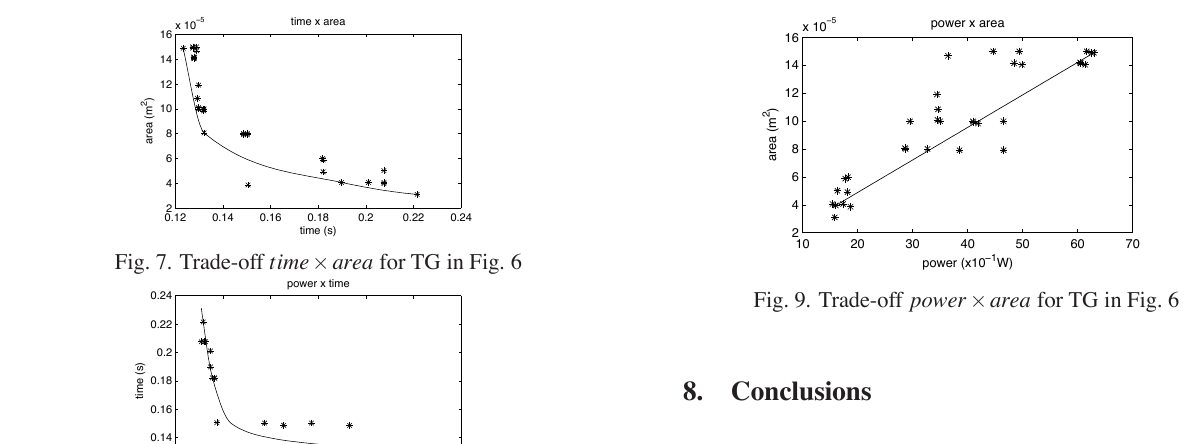
Fig. 9. Trade-off power × area for TG in Fig. 6